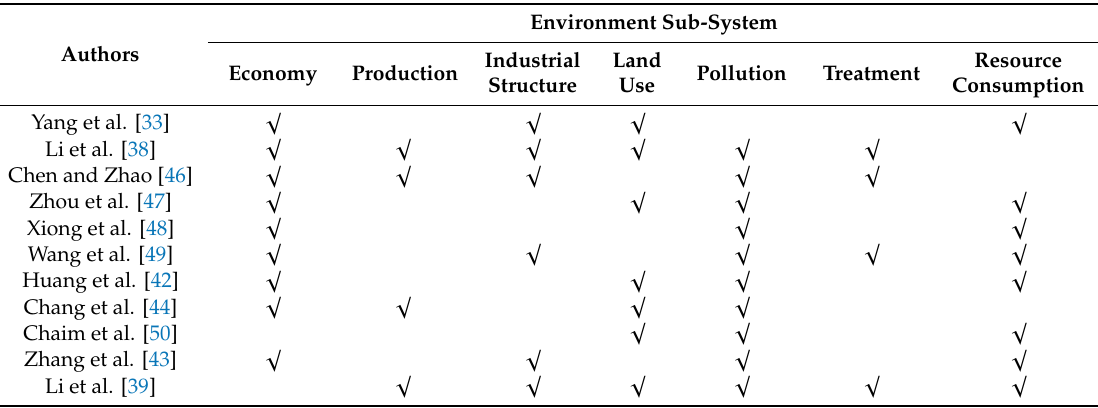
Table 1. Impact factors of industry–environmental system